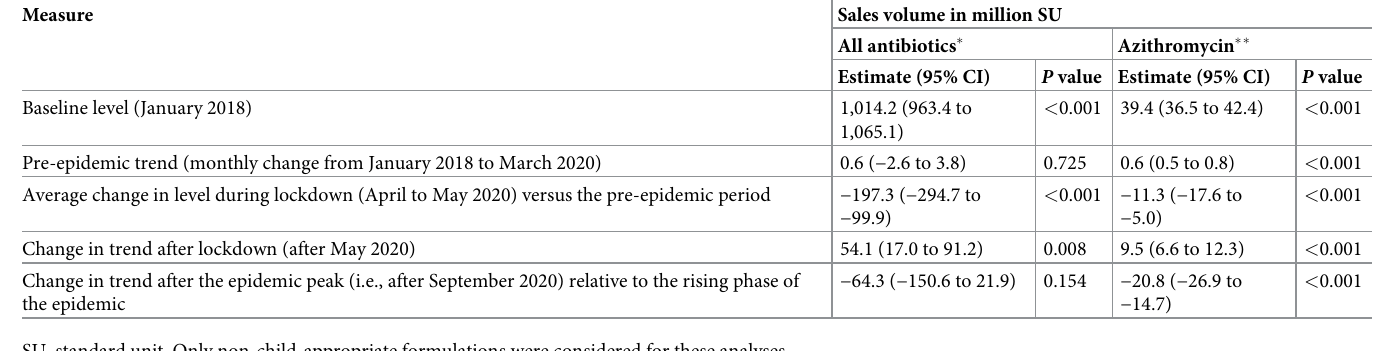
Table 2. Estimated change in monthly sales volume (expressed in million SU) according to adjusted segmented regression models for total antibiotics and azithromycin.